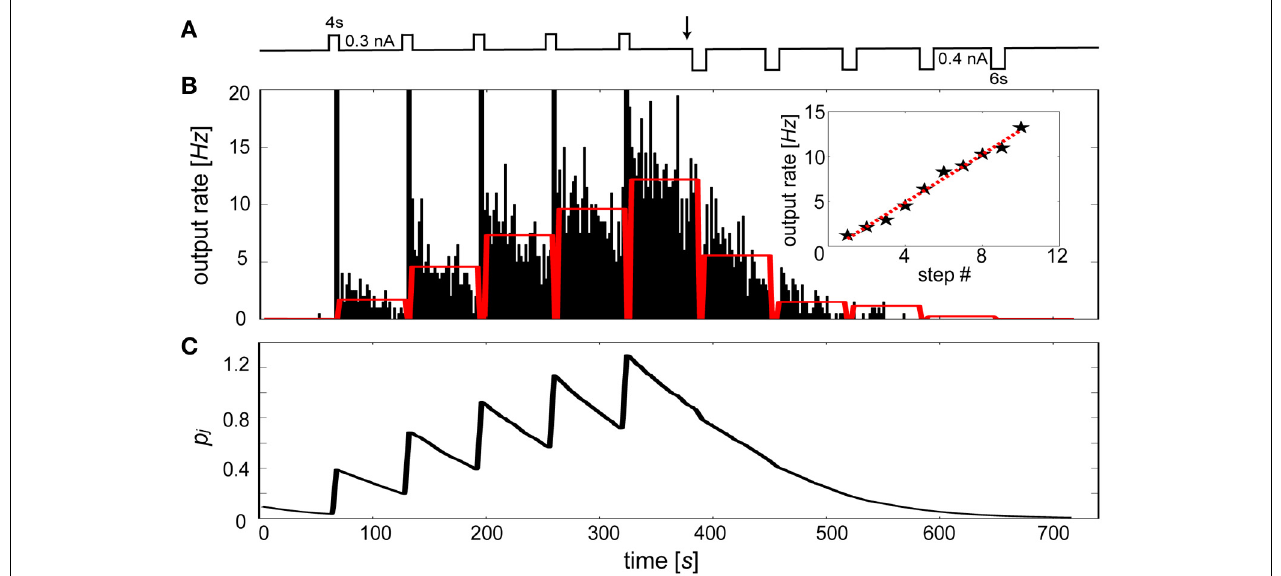
FIGURE 9 | The bias term reproduces the graded persistent activity found in entorhinal cortical neurons. (A) Stimulation protocol. Repetitive depolarizing followed by hyperpolarizing current injections (switch occurs at black arrow) of the IAF neuron including β j . (B) Peristimulus time histogram (2s bin width) of the